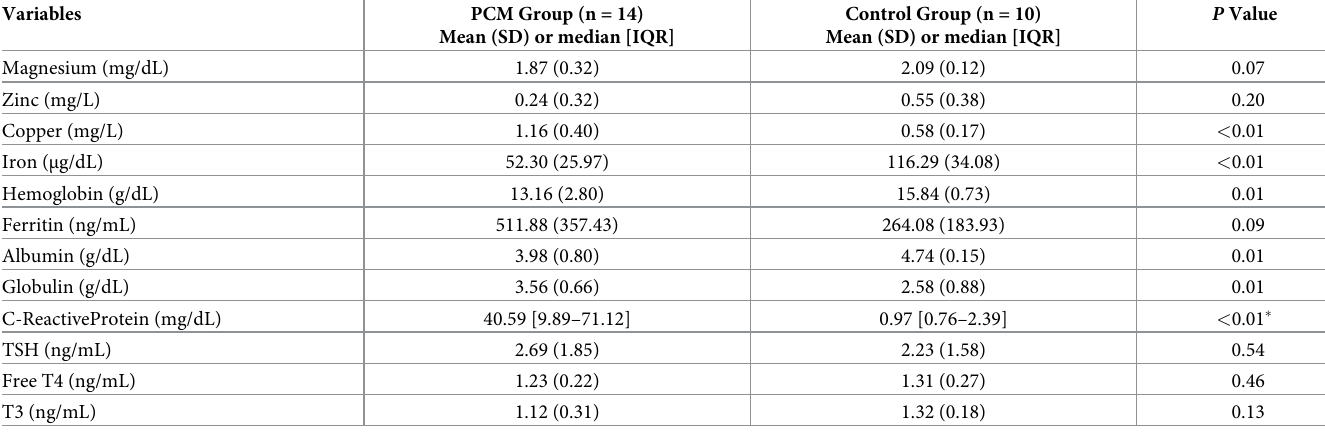
Table 3. Serum levels of minerals, proteins and thyroid hormones from 14 patients with paracoccidioidomycosis (PCM group) before treatment and from 10 healthy subjects (control group). Variables